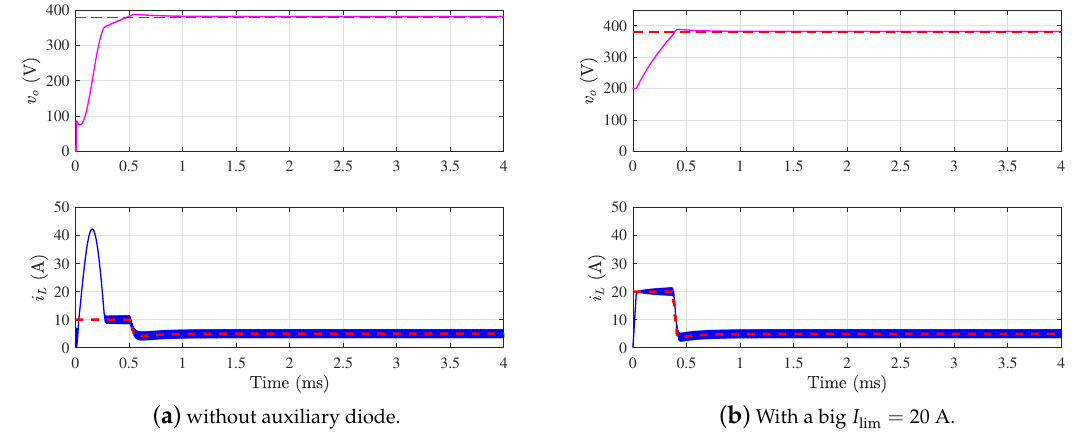
Figure 13. Startup and steady-state response from numerical simulations using a detailed switched model implemented in PSIM c (cid:13) revealing the importance of the auxiliary diode D a and the current limitation in guaranteeing the sliding-mode operation and hence the inrush current